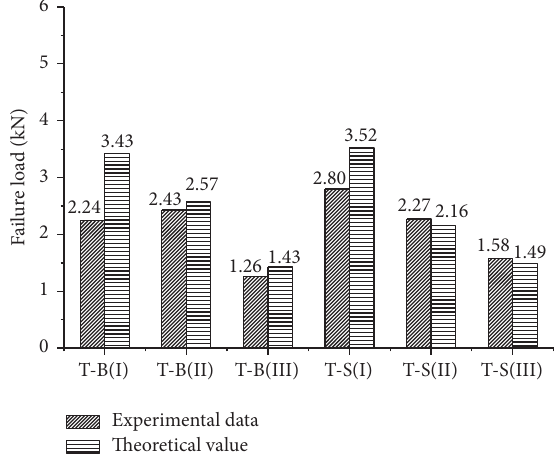
Figure 10: Comparisons of the tensile failure loads of the thin